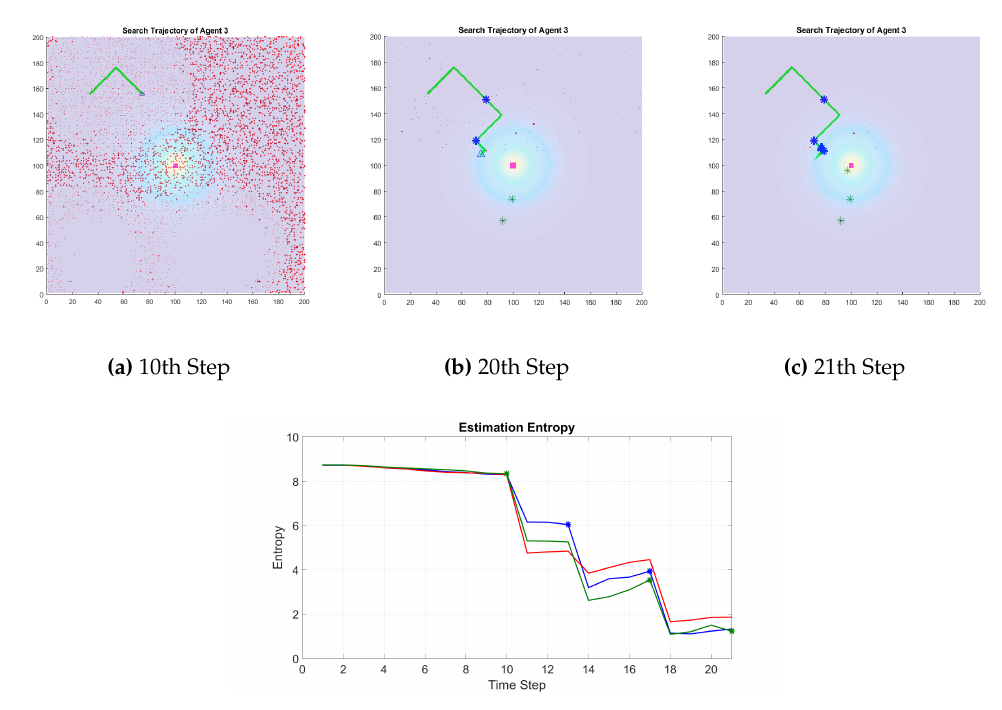
Figure 6. ( a – c ) The trajectory of a member of a group of three robots searching for the source of chemical dispersion. Each observation is communicated to the group and each member of the group use the information it gets from the others to manipulate its estimation. The green stars indicate the position where the other member of the group make a positive observation. ( d ) Variation of the entropy for the estimated probability distribution initially containing around 14,000 particles. Note that the size of the particles does not represent the associated weight of the